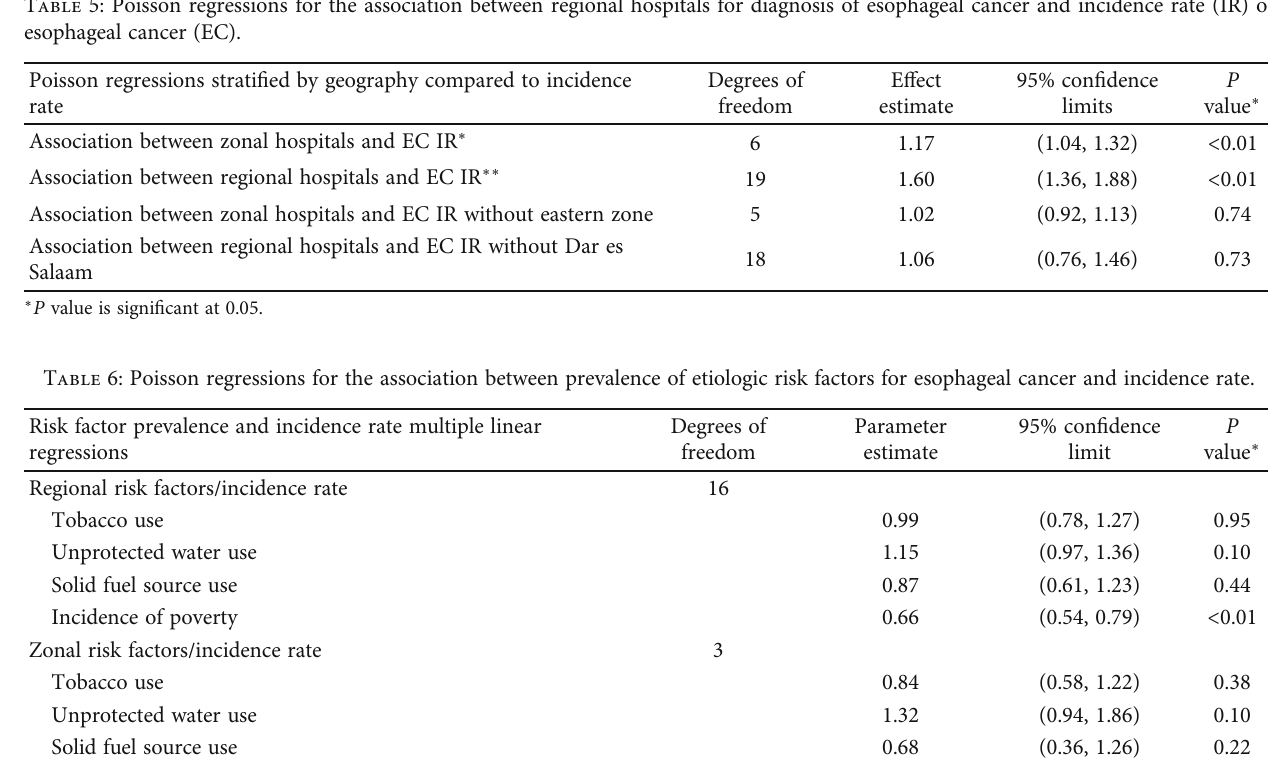
signi fi cant at a P value ≤ 0.05. Table 5: Poisson regressions for the association between regional hospitals for diagnosis of esophageal cancer and incidence rate (IR) of esophageal cancer (EC). Poisson regressions strati fi ed by geography compared to incidence rate